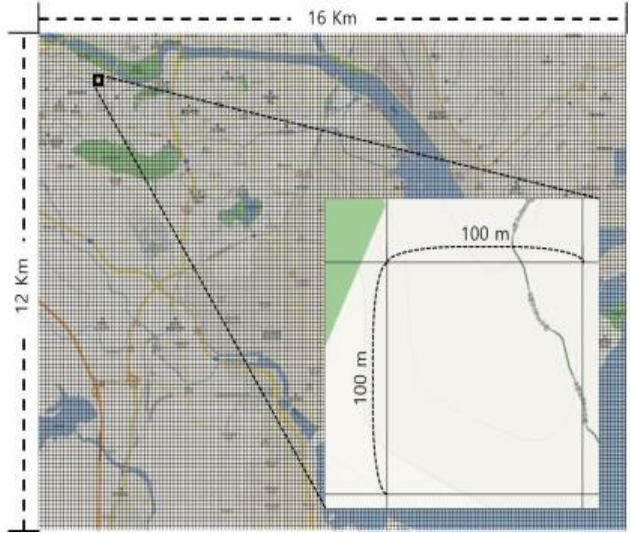
Figure 1. Operating range of the multimedia environmental monitoring model.